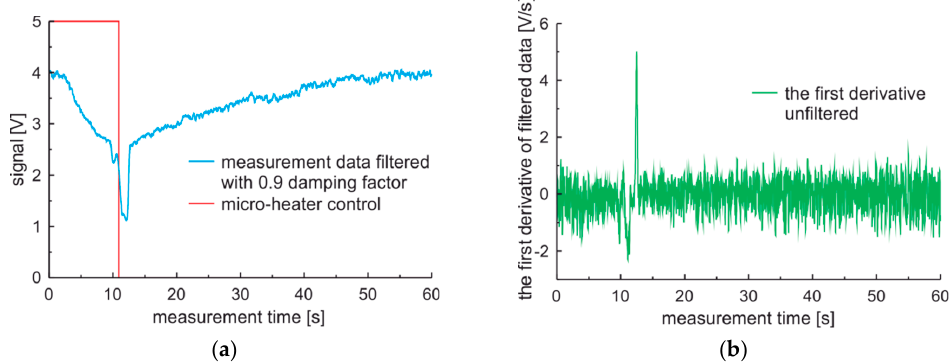
Figure 9. Filtered signals of the measurement cycle obtained for 100% bio-diesel fuel for the sensor located in an area with saturated WiFi transmission: ( a ) Filtered signal; ( b ) The first derivative of the filtered signal.